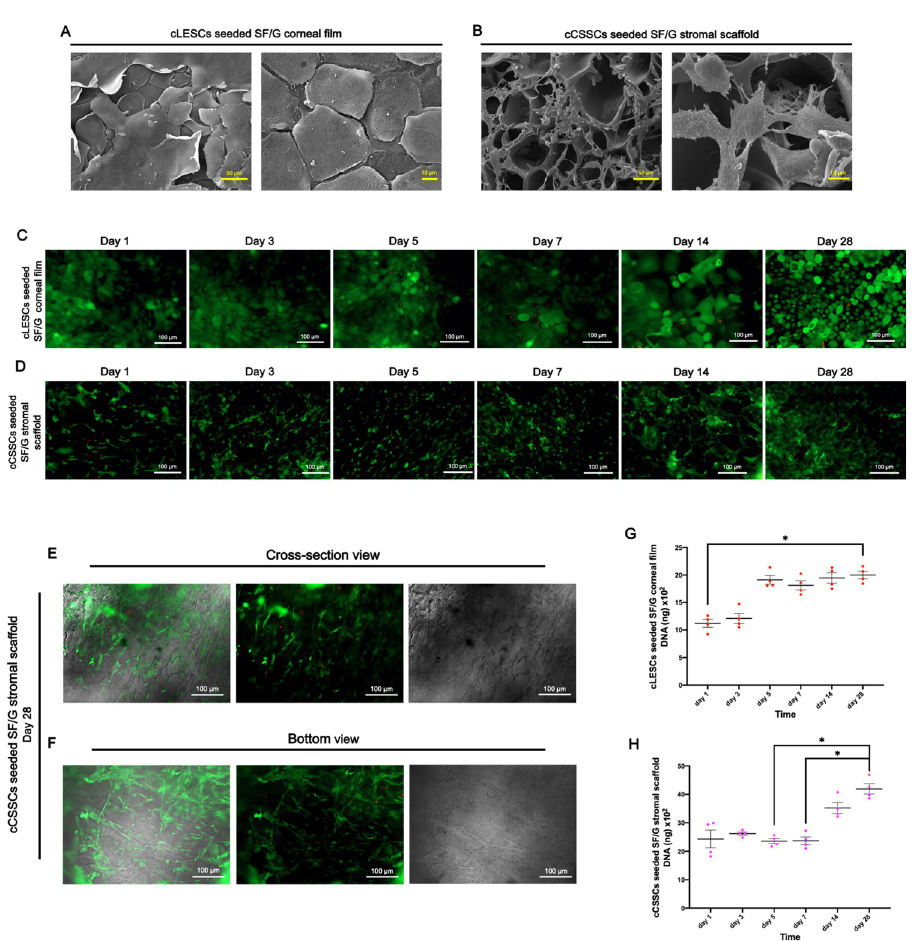
Fig 4. cLESCs seeded SF/G corneal film and cCSSCs seeded SF/G stromal scaffold. Scanning electron microscope (SEM) images of cLESCs seeded SF/G corneal film (350x and 1000x magnification) (A) and cCSSCs seeded SF/G stromal scaffold (350x and 1500x magnification) (B) at 14 days of culturing. Fluorescent images of live/dead staining of cLESCs seeded SF/G corneal film (C) and cCSSCs seeded SF/G stromal scaffold (D) at days 1, 3, 5, 7, 14, and 28 (100x magnification). Fluorescent images of live/dead staining, brightfield (BF), and merges at the cross-section view (E) and the bottom view (F) of cCSSCs seeded SF/G stromal scaffold at day 28 (100x magnification). Cell proliferation assay shows the proliferation pattern of cLESCs seeded SF/G corneal film (G) and cCSSCs seeded SF/G stromal scaffold (H) at days 1, 3, 5, 7, 14, and 28. All the data are expressed as means ± standard error of mean (SEM) (n = 4) ( � p < 0.05). The scale bars present 50 and 10 μ m (A, B) and 100 μ m (C, D, E,